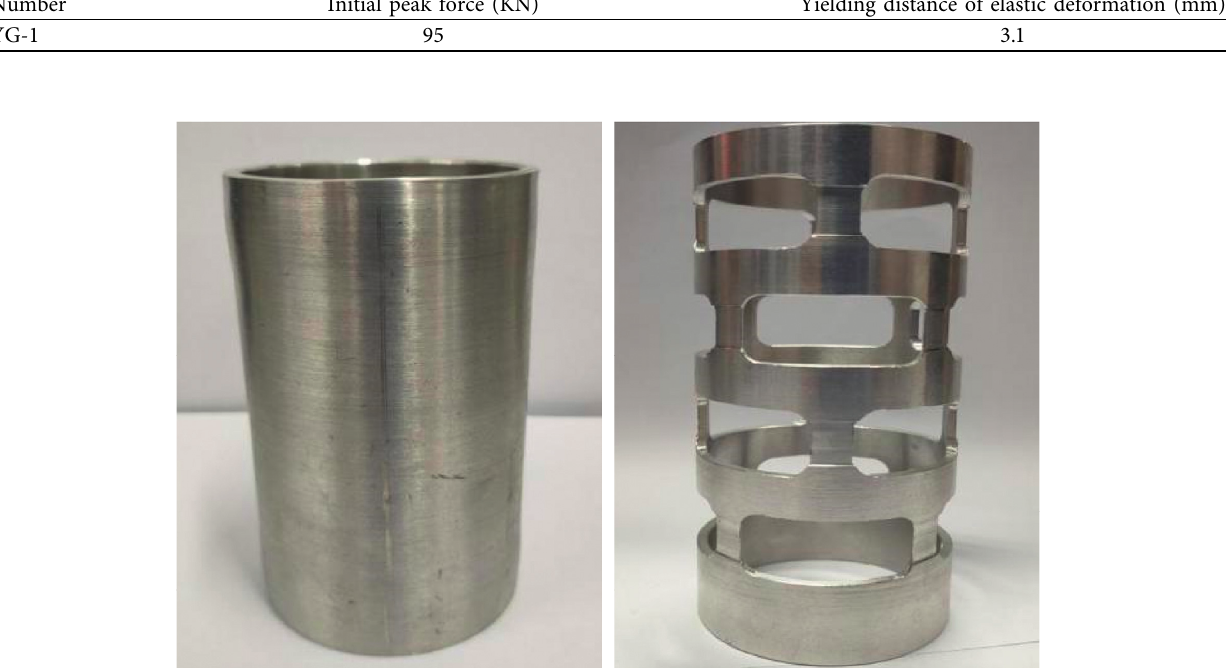
Figure 7: Thin-walled round tube crushing